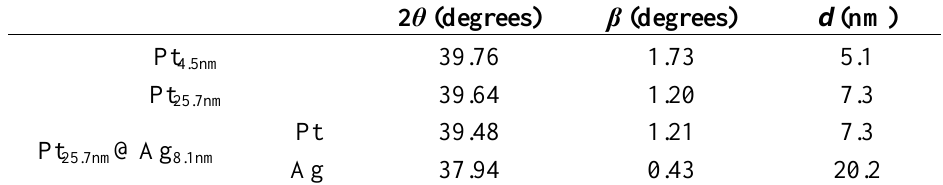
Table 1. Peak parameters and mean crystalline size derived from Scherrer analysis of the 111 peaks in XRD patters.